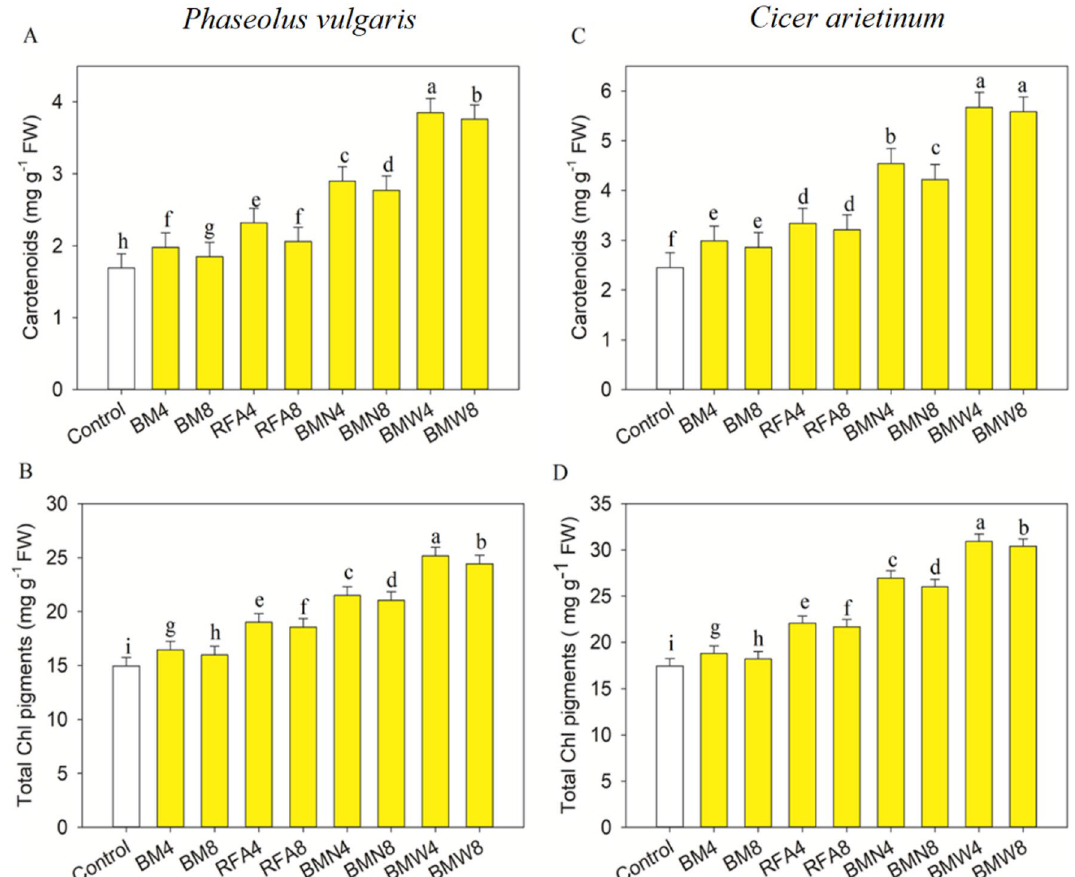
Figure 5. Impact of CNP treatment on the carotenoids and total chl pigments of Phaseolus vulgaris ( A,B ) and Cicer arietinum ( C,D ) seedlings. The bars represent the standard deviations (SD) of three replicates, and the different letters denote treatment differences that are statistically